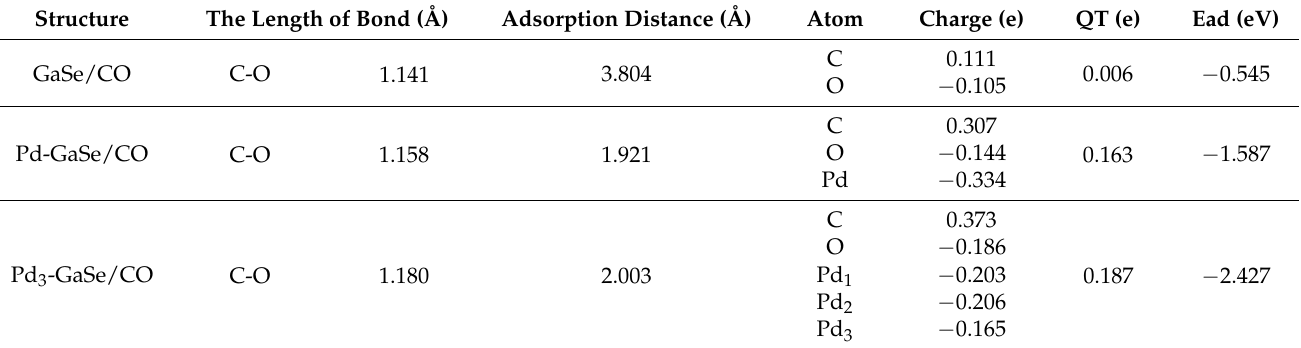
Table 2. Adsorption characteristic parameters of CO